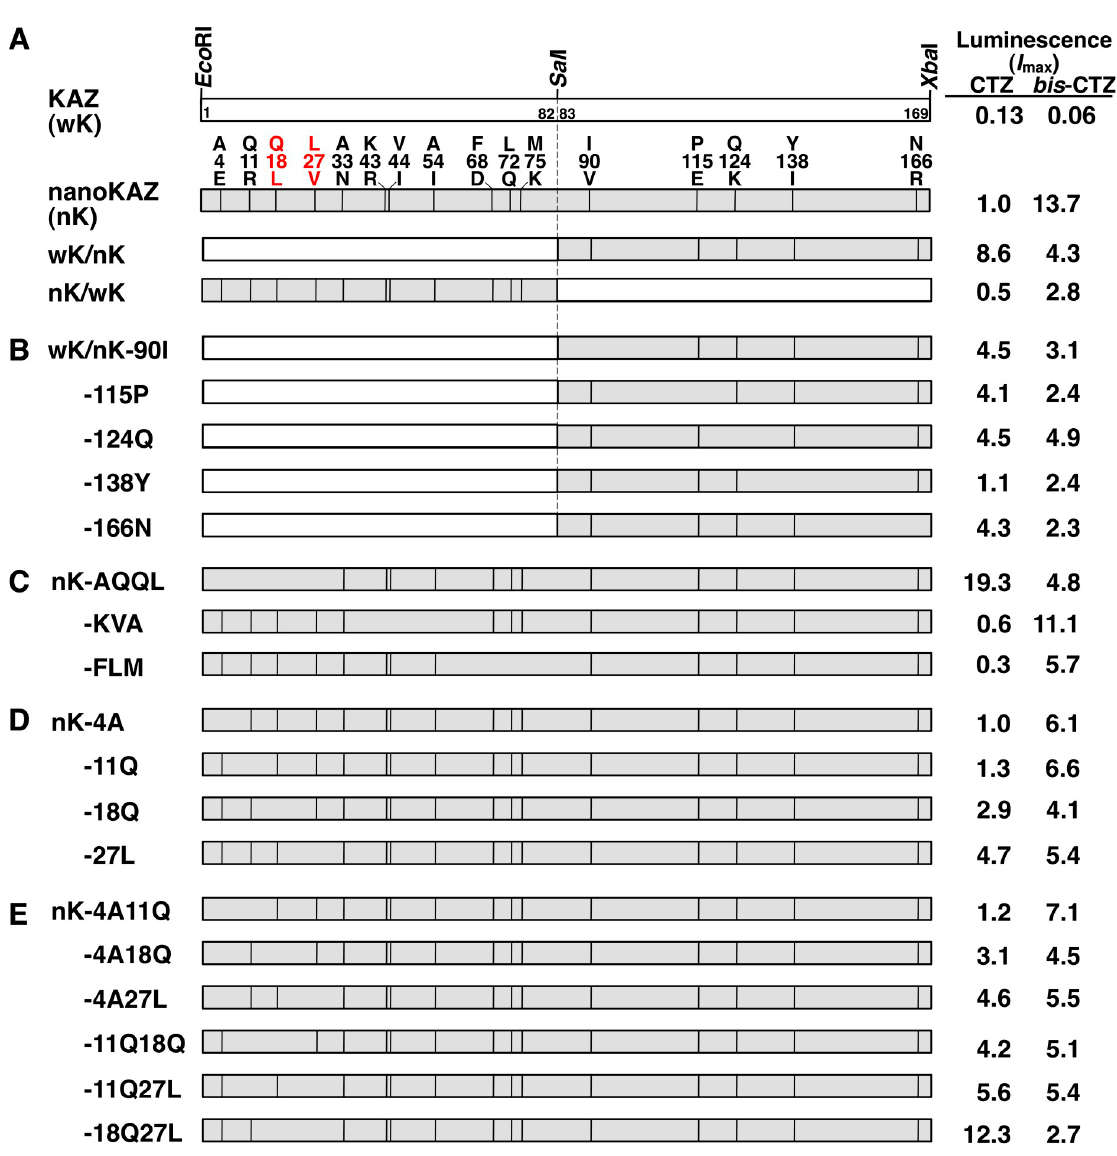
Fig 2. Schematic representation of the reverse mutants for nanoKAZ (nK) and their luminescence activities using coelenterazine (CTZ) and bis -coelenterazine ( bis -CTZ) as substrates. A. Chimeric proteins between wild KAZ (wK) and nanoKAZ (nK). wK/nK, 1–82 aa of wK and 83–169 aa of nK; nK/wK, 1–82 aa of nK and 83–169 aa of wK. B. Reverse mutants of wK/nK chimera with a single amino acid substitution at the carboxyl terminal region of nanoKAZ (83–169 aa). C. Reverse mutants of nanoKAZ with three or four amino acid substitutions at the amino- terminal region of nanoKAZ (1–82 aa). D. Reverse mutants of nanoKAZ with a single amino acid substitution at the amino-terminal region of nanoKAZ (1–27 aa). E. Reverse mutants of nanoKAZ with double amino acid substitutions at the amino- terminal region of nanoKAZ (1–27